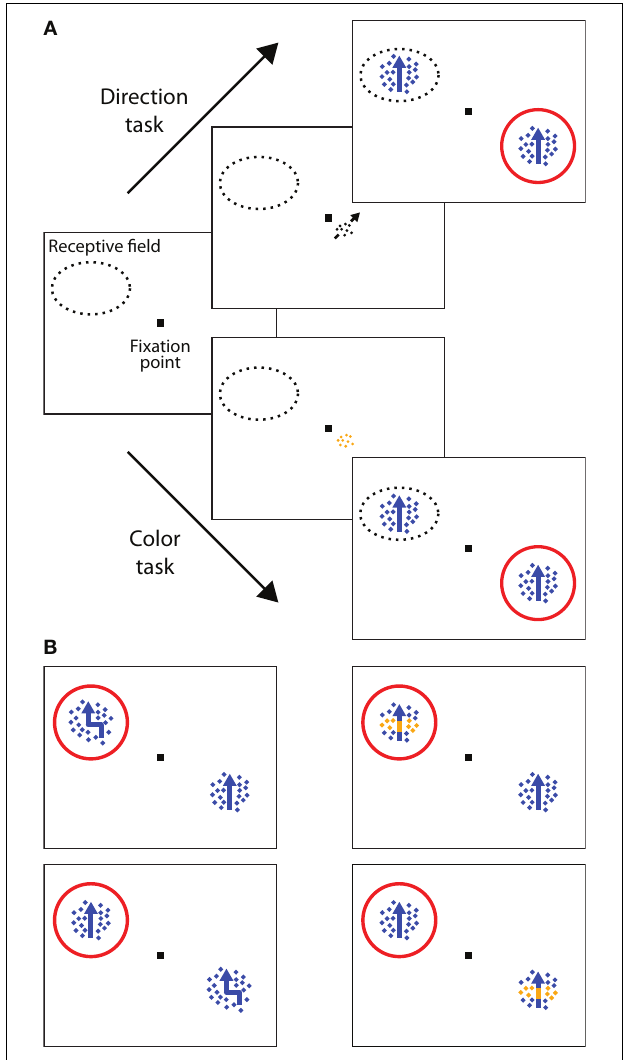
FIGURE 1 | Selective attention task. (A) Examples of the trial sequences for the direction task (upper sequence) and color task (lower sequence). After the monkeys fi xated and depressed a lever, a small cue briefl y appeared (500 ms), indicating the spatial location of the upcoming target stimulus and the attentional task to be performed. In the direction task, the cue was a small, achromatic moving RDP and instructed the monkey to respond, by releasing the lever, to a change in direction of the cued stimulus (the target). In the color task, the cue was a stationary, colored RDP, instructing the monkey to respond to a change in the color of the target. After cue offset, two moving RDPs were presented at equal eccentricity in opposite visual hemifi elds, one of them inside the RF of the neuron under study. Changes in the stimuli could occur 500–3550 ms following cue offset. The red circle indicates the spatial focus of attention. Examples of trial sequences in which the target stimulus was the one on the left are not shown here. (B) Target event and three different distractor events in the direction task. The monkeys were only rewarded for responding to a change in the direction of motion of the cued stimulus (top left panel). Trials were terminated without reward if they responded to any of the following distractor types: a change in the color of the cued stimulus (top right, dimension distractor), a change in the direction of motion of the uncued stimulus (bottom left, location distractor), or a change in the color of the uncued stimulus (bottom right, dimension and location distractor). Trials were also terminated without reward if the monkeys missed the target event or broke fi xation. Corresponding events were used in the color